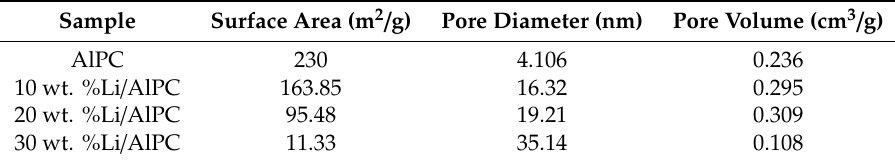
Table 1. Textural properties of the synthesis